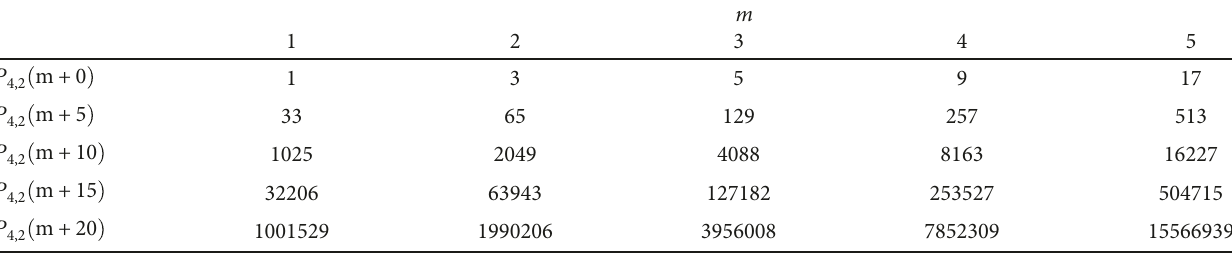
n sequence for n ≤ 25 . 4,2